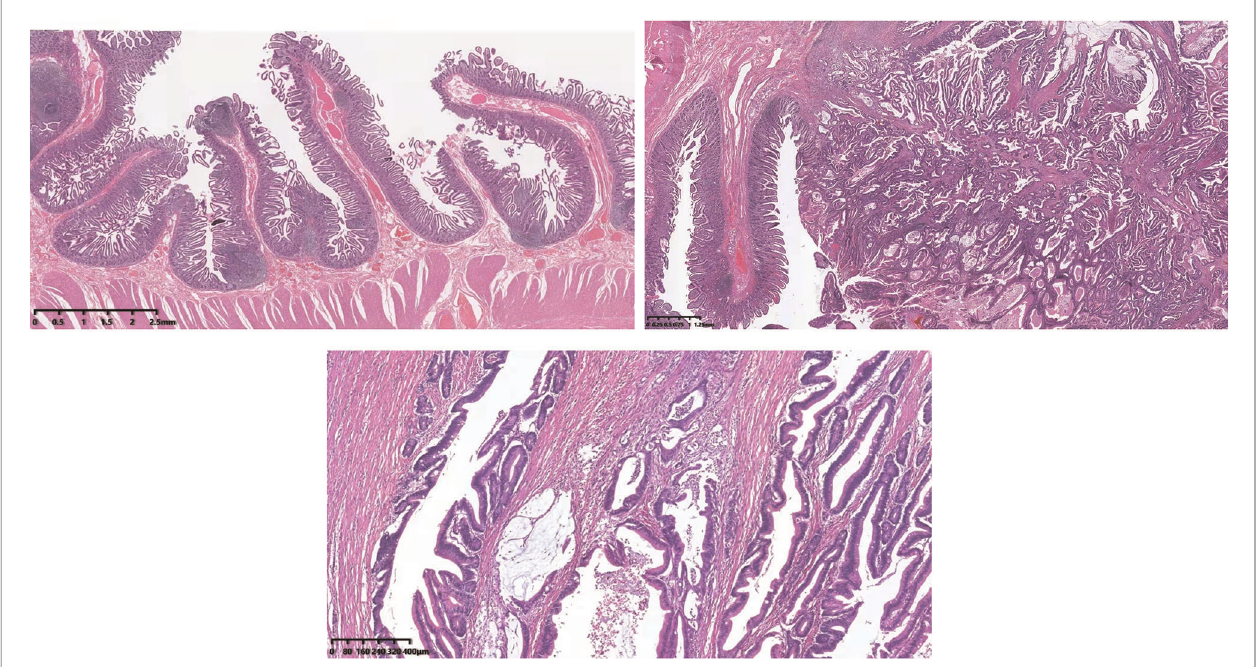
FIGURE 4 | Hematoxylin – eosin staining showed that adenocarcinoma cells formed glands or adenoid structures with different sizes, shapes, and irregular arrangements; the carcinoma tissue had in fi ltrated into the subserous